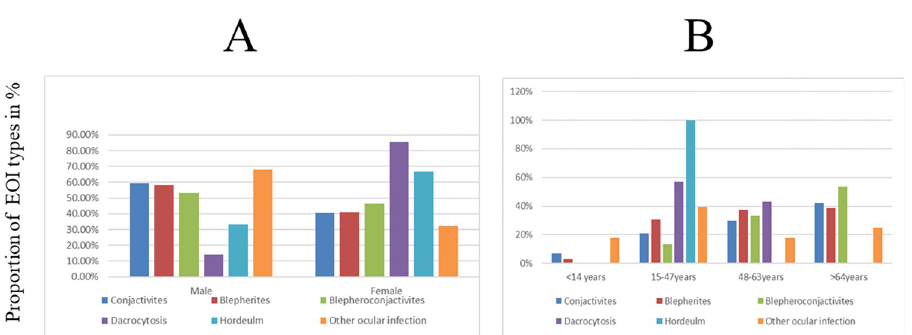
Fig 1. Distribution of external ocular infection among patients stratified by gender (A) and age group (B) at DMCSH, Northwest,